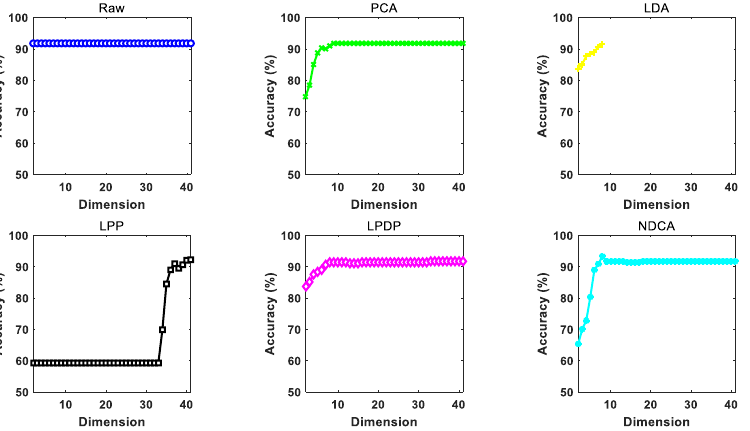
Figure 8. The performance of different dimension reduction methods under different reduced dimensions using SVM as the classifier.